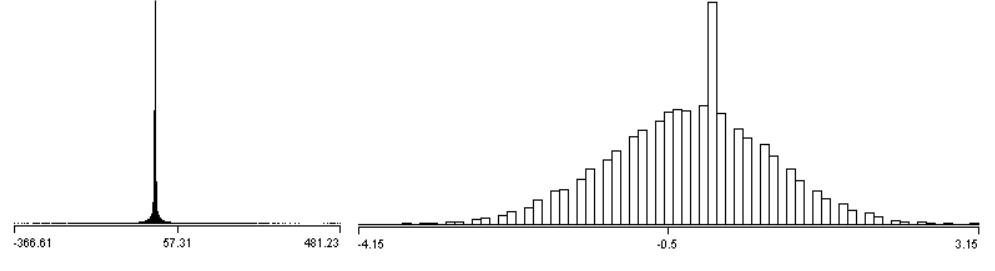
Figure 1. EEG original data sets obtained from CONTEC KT88 ( electrodes 7 and 17 ).